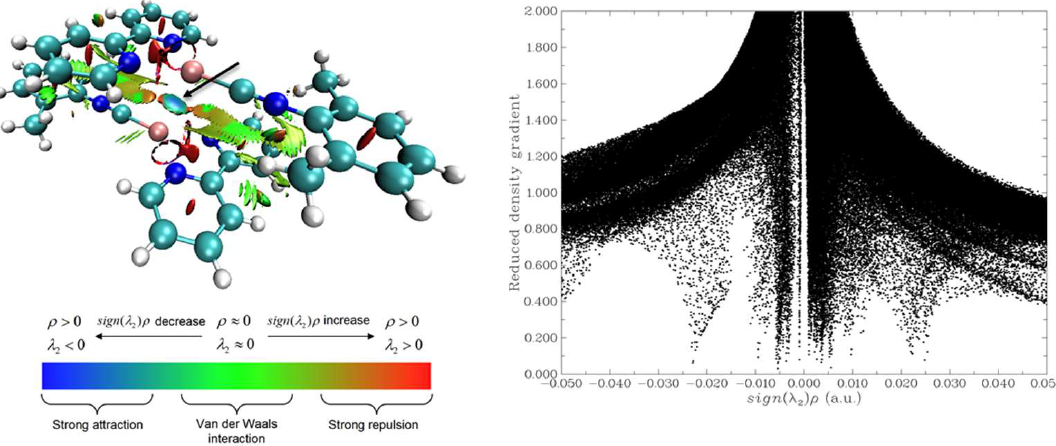
Figure 3. Visualization of intermolecular contacts in 3D using NCI analysis technique and NCI plot for 4 . Blue area responsible for attractive aurophilic interactions Au(I)···Au(I) indicated by black arrow.